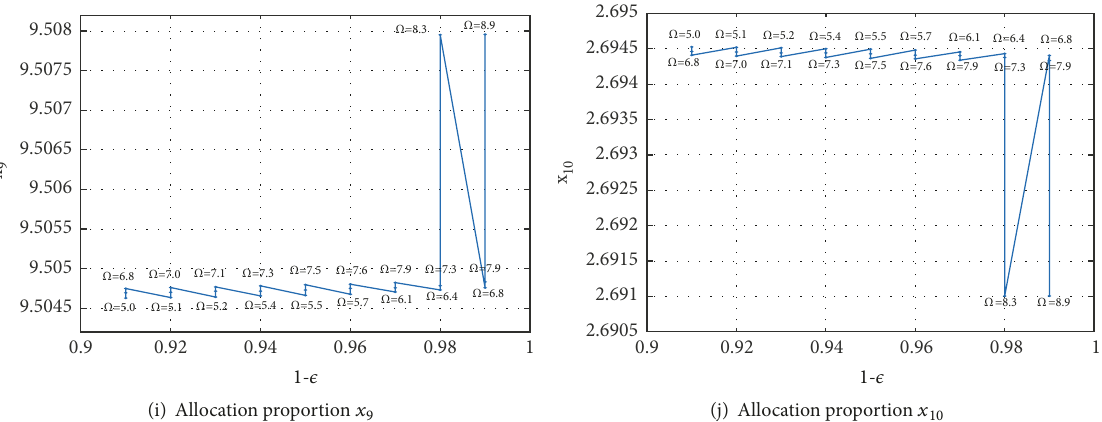
Figure 6: The variation of optimal portfolio strategies in Case II under different risks.